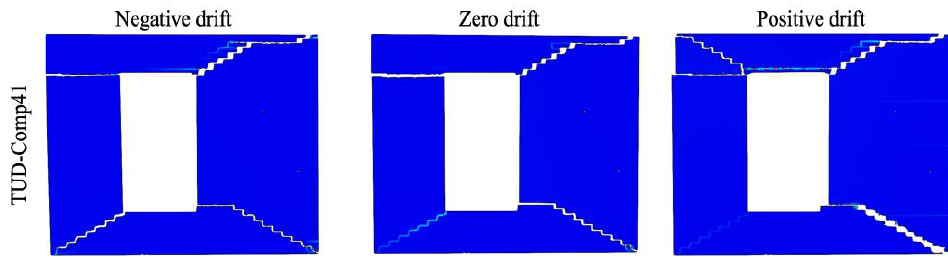
Figure 10. Failure mechanism of the unstrengthened wall (TUD-Comp41) resulting from the ULS protocol at a displacement of 40 mm (1.6/ − 1.5% drift).